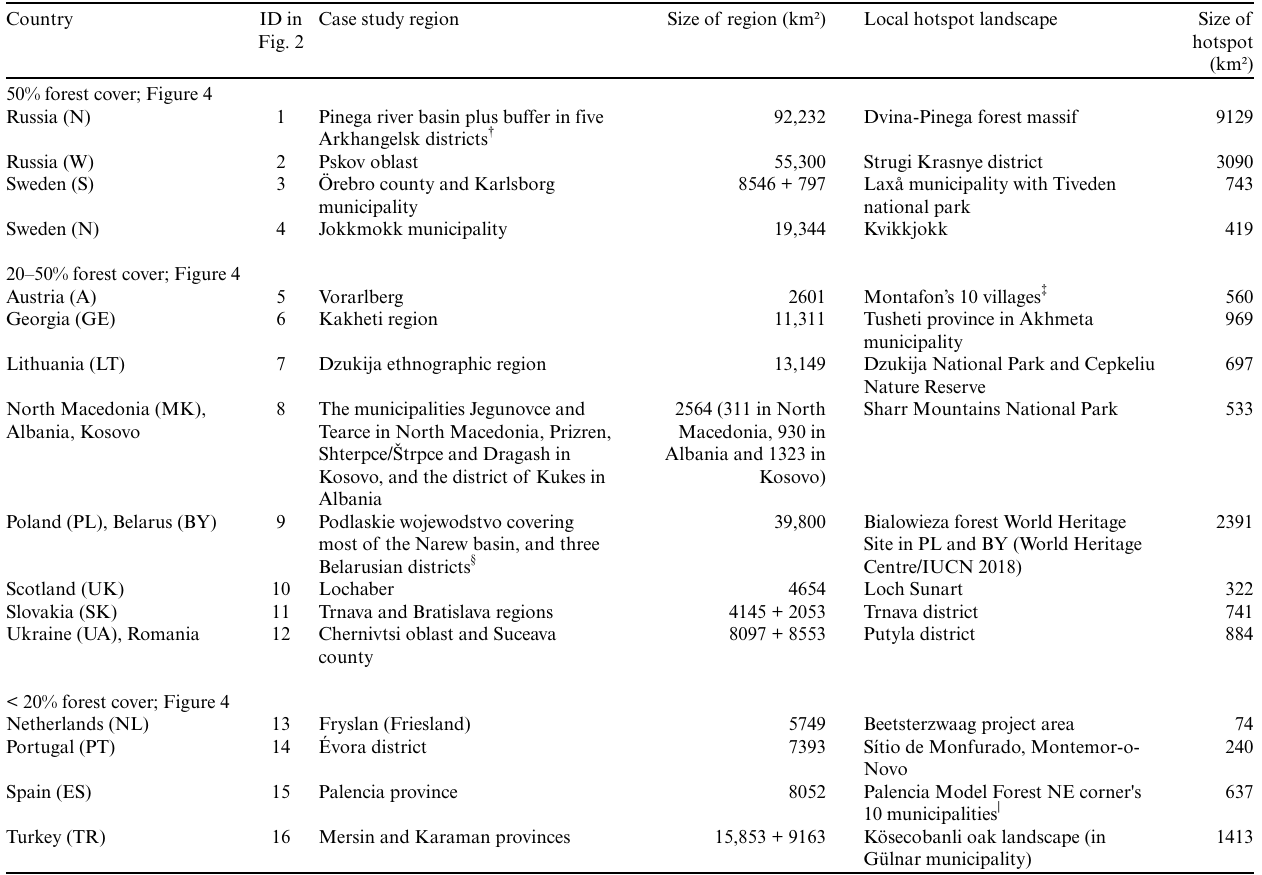
Table 1 . List of case study regions and constituent local “hotspot” landscapes chosen on the European continent. Country ID in Case study Fig. 2